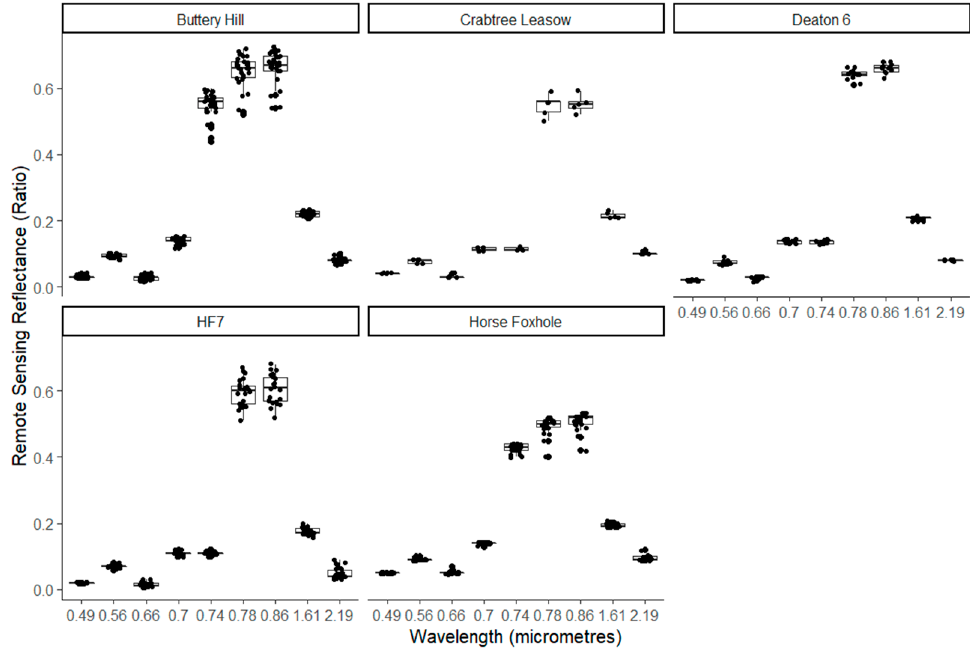
Figure 3. Illustration of the observed spread of the peak reflectance values of the nine Sentinel-2 wavelengths observed during the growing period at five study sites.